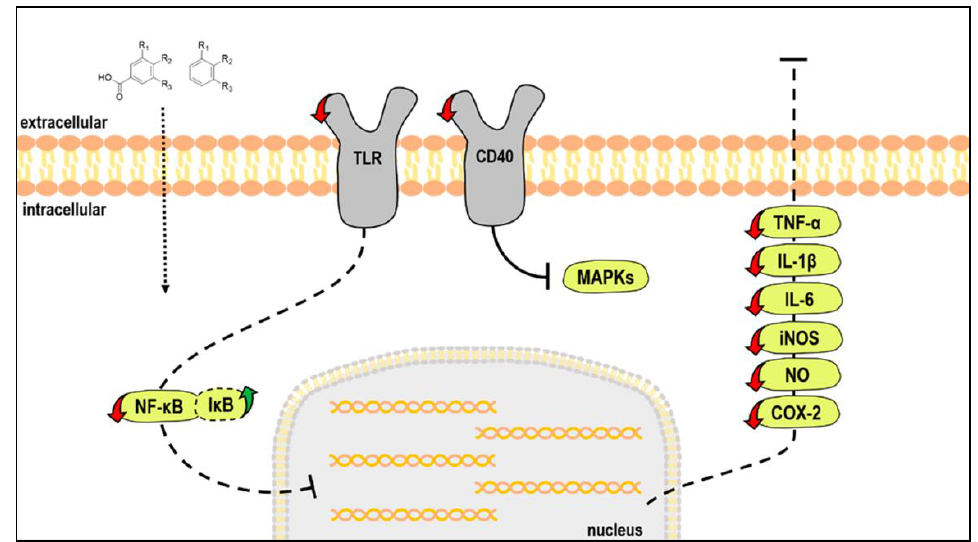
Figure 2. Main molecular targets of low-molecular weight polyphenols metabolites in stimulated microglia cells. [17].